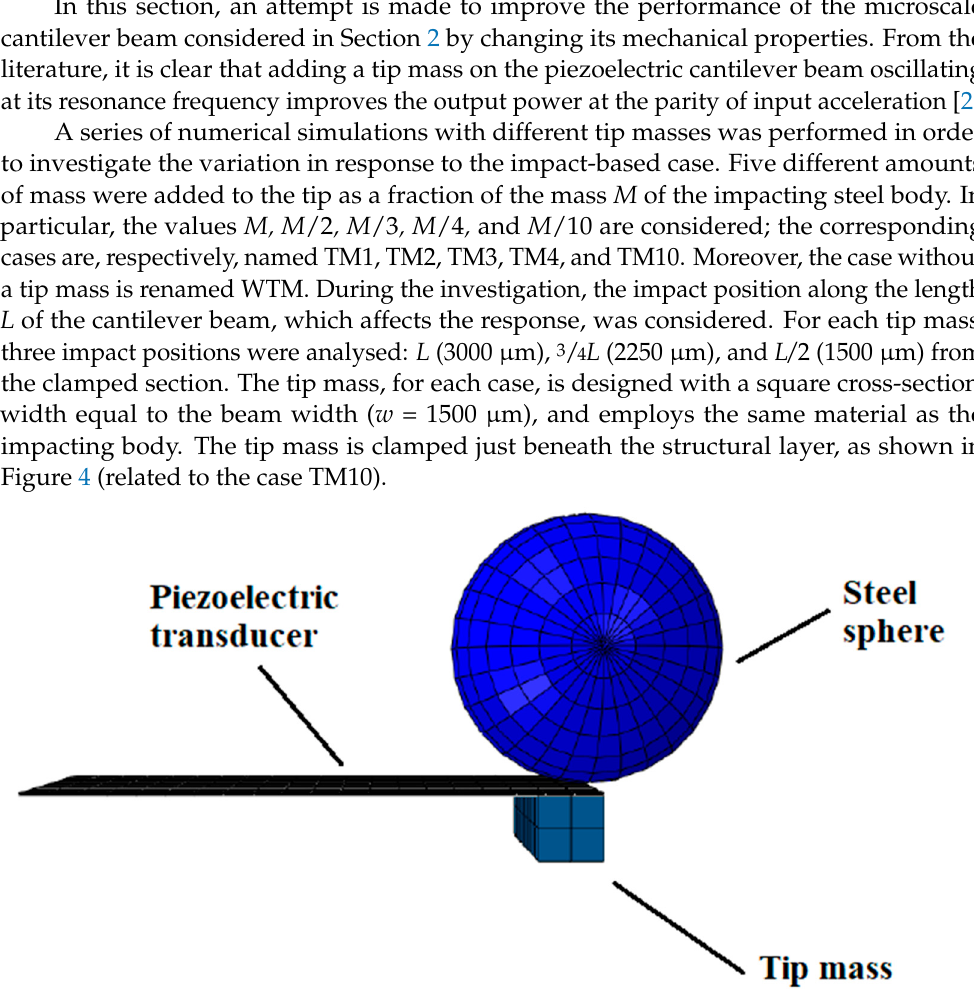
Figure 4. Finite element model at the instant of impact: case with tip mass equal to 1/10 of the sphere mass.